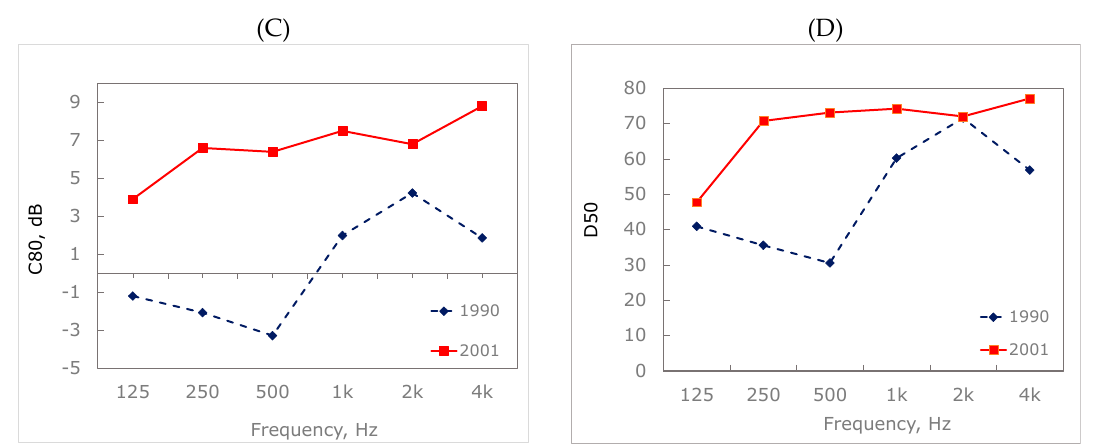
Figure 14. Measured parameters in S. Dominic of Foligno, performed in 2001. ( A ) EDT; ( B ) T 20 ; ( C ) C 80 ; ( D ) D 50 .